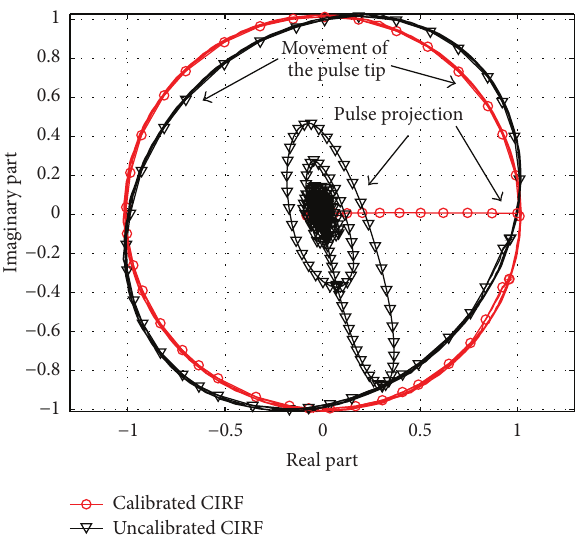
Figure 6: Projections of normalized CIRFs into 𝐼 - and 𝑄 -plain before and after calibration.